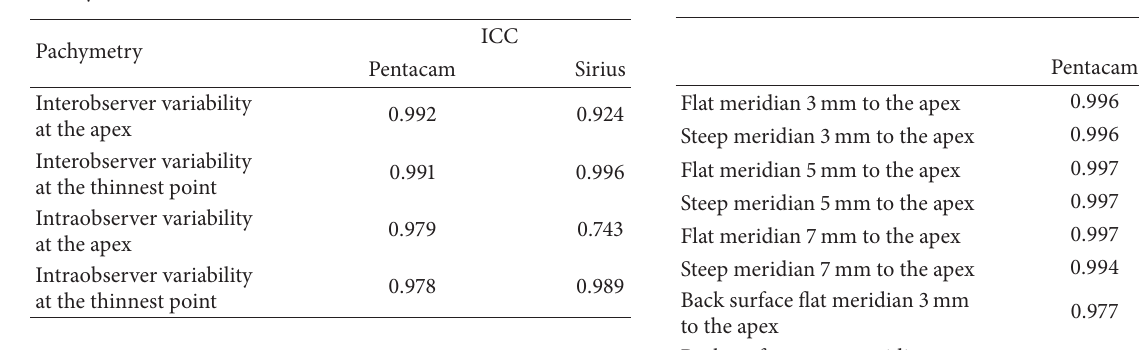
Table 1: Intra- and interobserver variability of pachymetry in healthy corneas (ICC = intraclass correlation coefficient).